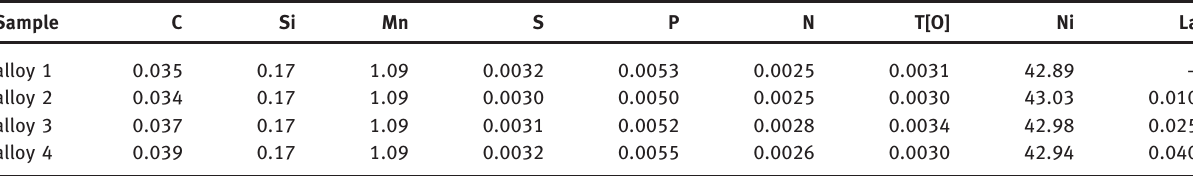
Table 1: Chemical compositions of all tested alloys/(mass%). Sample